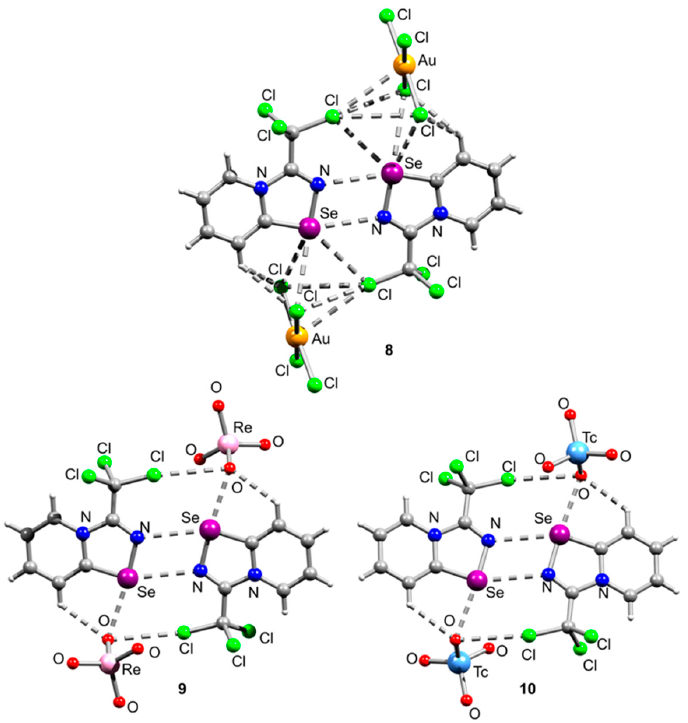
Figure 4. Ball-and-stick representations of the crystal structures of 8 – 10 . Grey and light-grey spheres represent carbon and hydrogen, respectively.